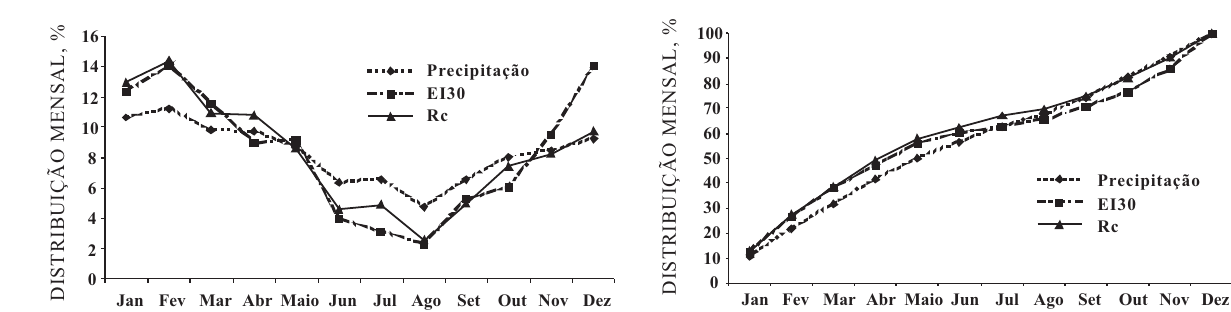
Figura 2. Distribuição percentual acumulada da e coeficiente de precipitação pluvial, índice EI 30 chuva em Quaraí-RS, no período 1966-2003.